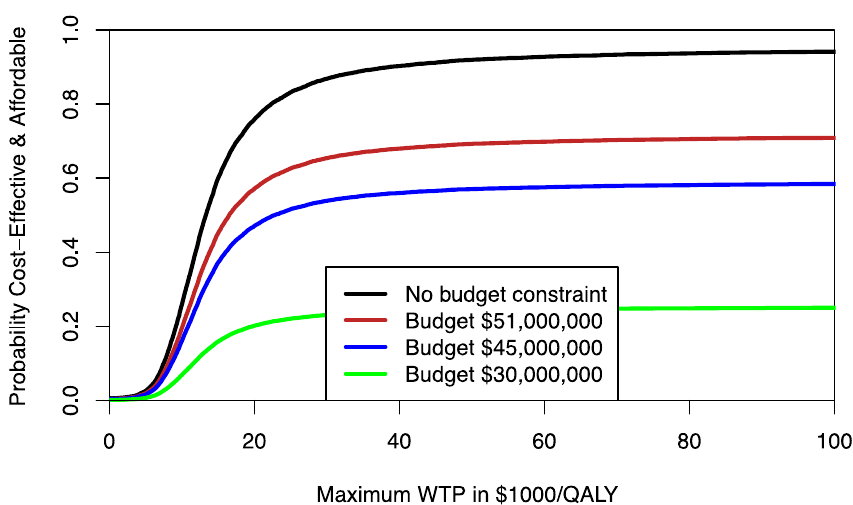
Figure 2. Cost-effectiveness affordability curves (CEAFCs) for different budget constraints comparing program F to program E. Without any budget constraint, the CEAFC corresponds to the CEAC.